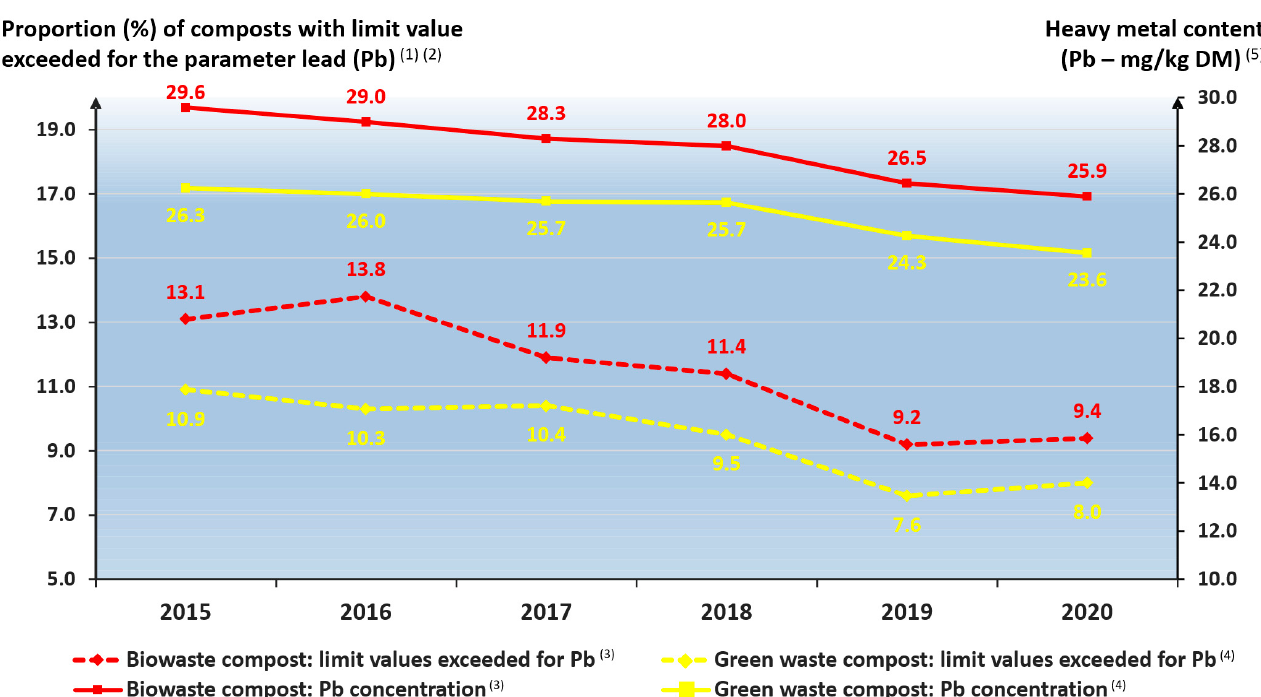
Figure 7. Comparison of the average lead (Pb) content of quality-assured biowaste and green waste composts with the proportion of limit value exceedances for lead (Pb) in relation to compost suitability in organic farming in Germany in 2015–2020 (composts according to RAL-GZ 251 Compost of BGK in Germany in 2015–2020) (1) . (1) Limit values ( ≤ ) according to EU-ÖkoV—EU Regulations on organic farming (Regulation (EC) No. 889/2008, Annex 1 resp. 2021/1165, Annex 2). (2) Proportion of composts with limit values exceeded for the parameter lead (Pb) = Proportion of composts unsuitable for organic farming in % of all composts of RAL Quality Assurance 251 Compost (BGK 2016–2021). (3) n = 1856 in 2015, n = 1857 in 2016, n = 1843 in 2017, n = 1900 in 2018, n = 1874 in 2019, n = 1899 in 2020, data from RAL quality assurance 251 compost (BGK, 2016–2021). (4) n = 1416 in 2015, n = 1488 assurance 251 compost (BGK, 2016–2021). (5) Median